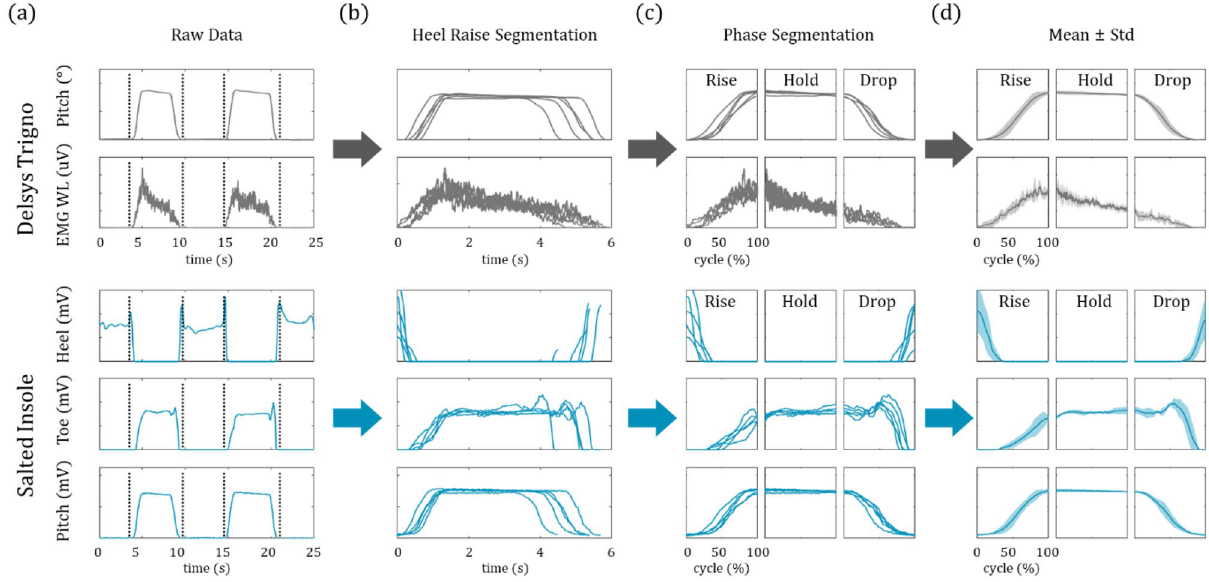
Figure 2. Automatic segmentation of heel raise events and data processing. ( a ) The data acquired from Delsys Trigno sensors and insoles are first synchronized. The initiation and termination of the heel raise events are determined by applying a simple threshold on foot pitch. ( b ) The synchronized signals are then collectively segmented and the rise, hold and drop phases are detected via pitch gradient. ( c ) The signals are further segmented into their respective phases and normalized along time axis such that they are represented in percentage of phase. ( d ) The mean and standard deviation are plotted against phase percentage as line and area,